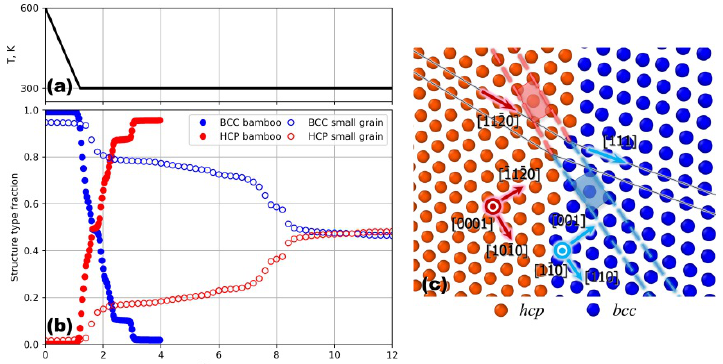
Fig. 3. Kinetics and mechanism of the martensitic β→α phase transitions in bamboo-like coarse grain and fine grain samples. (a) – temperature of the thermostat during cooling from T =600 K down to room temperature; (b) – fraction of atoms of bcc and hcp structures in the samples; (c) – mutual orientation of prior β and daughter α phases during the martensitic β→α phase transition.